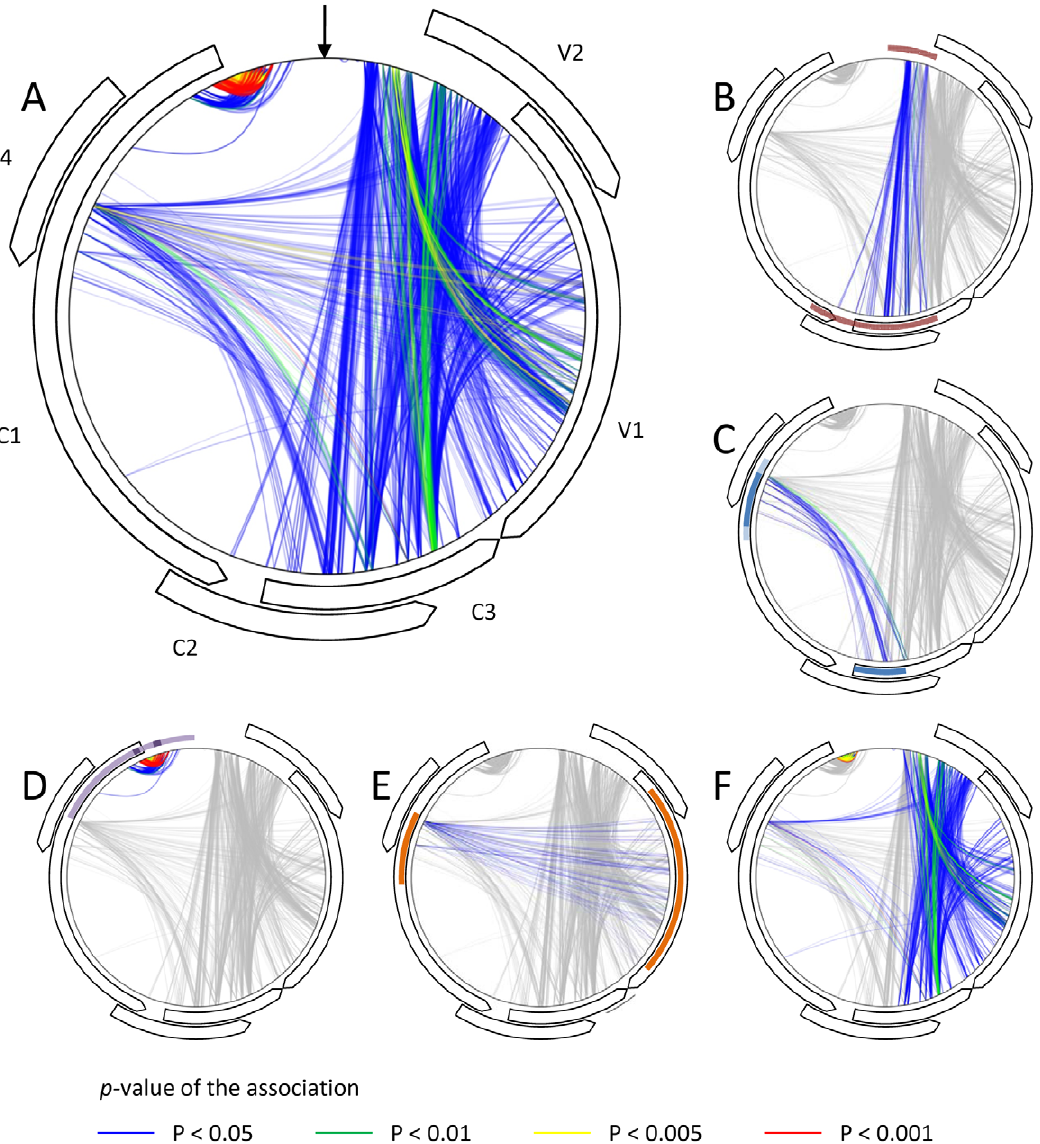
Figure 5. Schematic representation of nucleotide associations implied by non-random patterns of recombination that occur during Tomatoyellowleafcurlvirus (TYX) and TomatoleafcurlComorosvirus (TOX) co-infections. Curved arrows indicate the positions of open reading frames (ORFs) and the vertical black arrow indicates the position of the origin of virion strand replication. The indicated p -values (represented by different colours) are for a pair permutation-based association tests such that, for example, a red line between two genomic sites indicates that a p -value , 0.001 was obtained for both the Chi-square based association test, and the test for lower than expected mixtures of TOX and TYX derived polymorphisms at the indicated pair of sites (i.e. both members of the pair tend to be inherited from the same parental virus). ( A ) All of the detected associations. ( B ) Associations potentially caused by the known interaction between the C3 gene product (the transcription activator protein) and the V1 and V2 gene promoter (the currently mapped sites for this interaction and the others below are indicated by coloured arcs; [32]). ( C ) The known interaction between the C1 gene product (the replication associated protein) and the C3 gene product (the replication enhancer protein; [30]) ( D ) The known interaction between the C1 gene product and the C1 proximal portion of the intergenic region (indicated by light purple arcs; [33–34]). The bioinformatically mapped sites of so-called iterons (within the intergenic region) and iteron related domains (within the replication associated protein) believed to be the specificity determinants of this interaction are indicated by darker purple arcs [31]. ( E ) The known interaction between the V1 gene product (the coat protein) and the C1 gene product [50]. ( F ) Associations potentially caused by as yet unknown interactions between the V1 and V2 genes/gene products, the V1 gene/gene product and the intergenic region, and between the C3 and V2 genes/gene